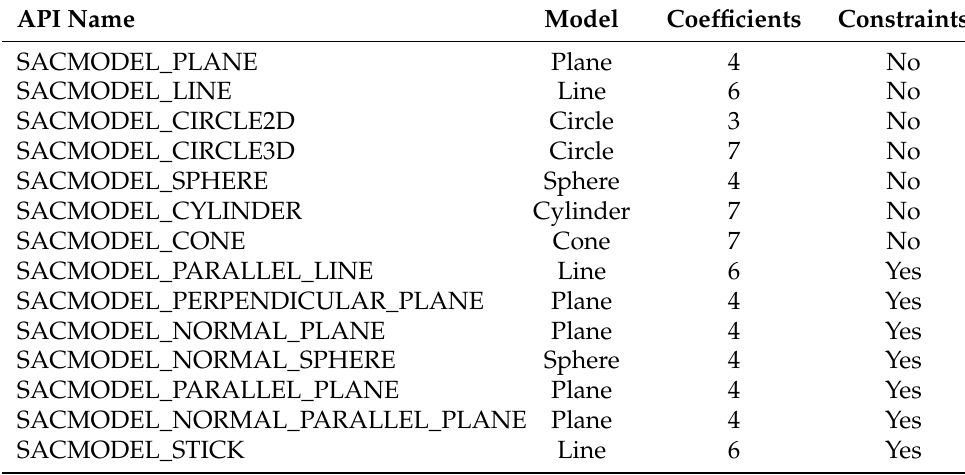
Table 3. List of models available in PCL (as of 1.12.1